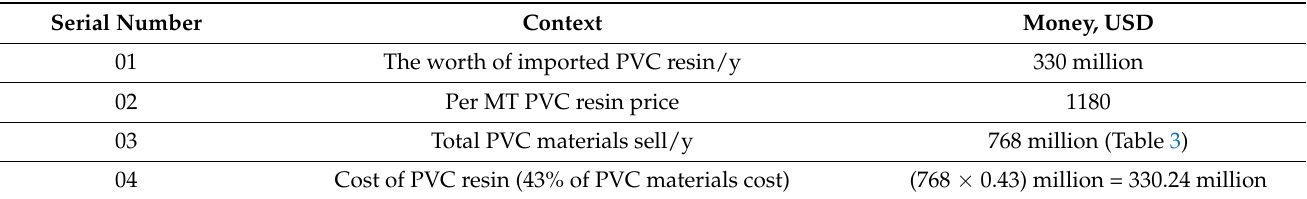
Table 4. Estimated Calculation for PVC Companies in Bangladesh (Calculation was made based on collected data from local sources).